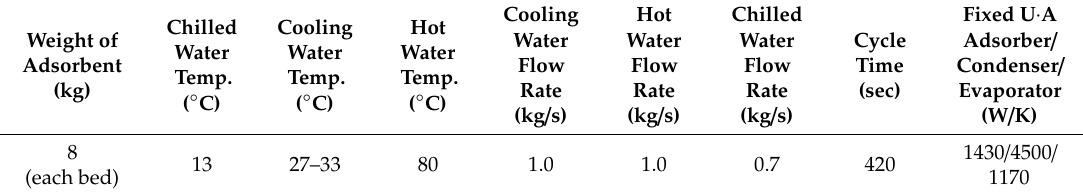
Figure 1. Picture of an adsorption chiller (AD) system. Table 1. Operating conditions of laboratory-scale